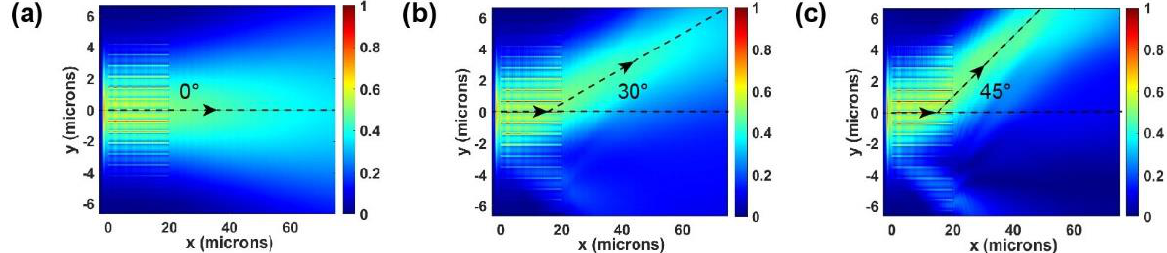
Figure 5. On-chip deflection realized by applying the linear gradient phase with designed voltages. ( a ) |E y | with no voltages applied; ( b ) |E y | when 30° on-chip deflection is realized. The maximum variation of the ordinary refractive index Δn omax = 0.0475 caused by the applied voltages; ( c ) |E y | when 45° on-chip deflection is realized. The maximum variation of the ordinary refractive index Δn omax = 0.095 caused by the applied voltages.